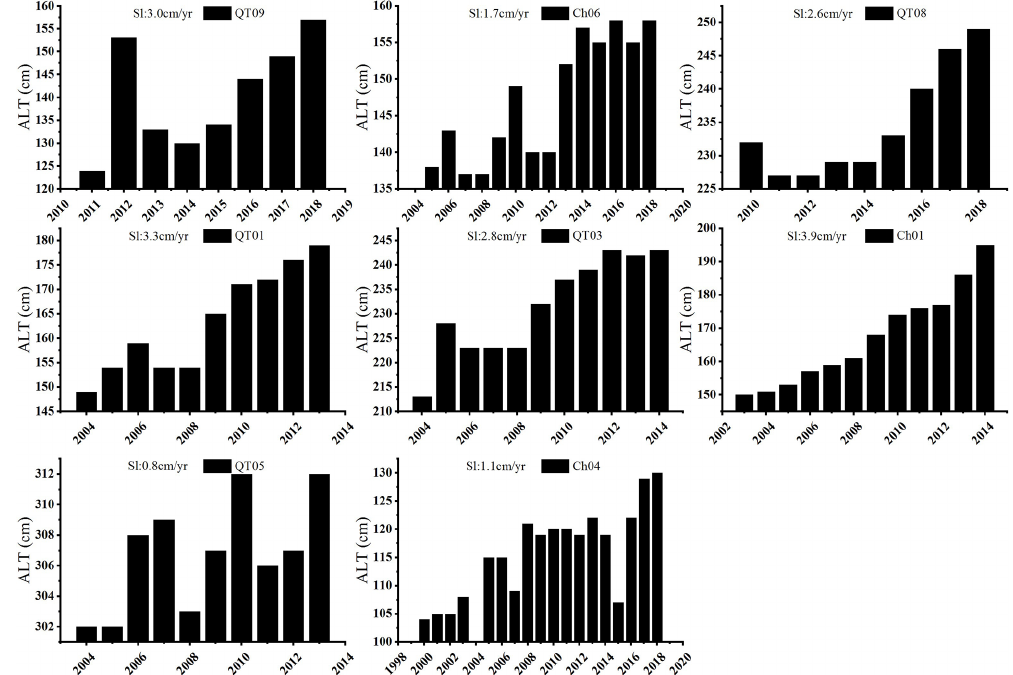
Figure 7. Variation in active layer thickness among different sites. SI represents the active layer thickness average annual increase rate.